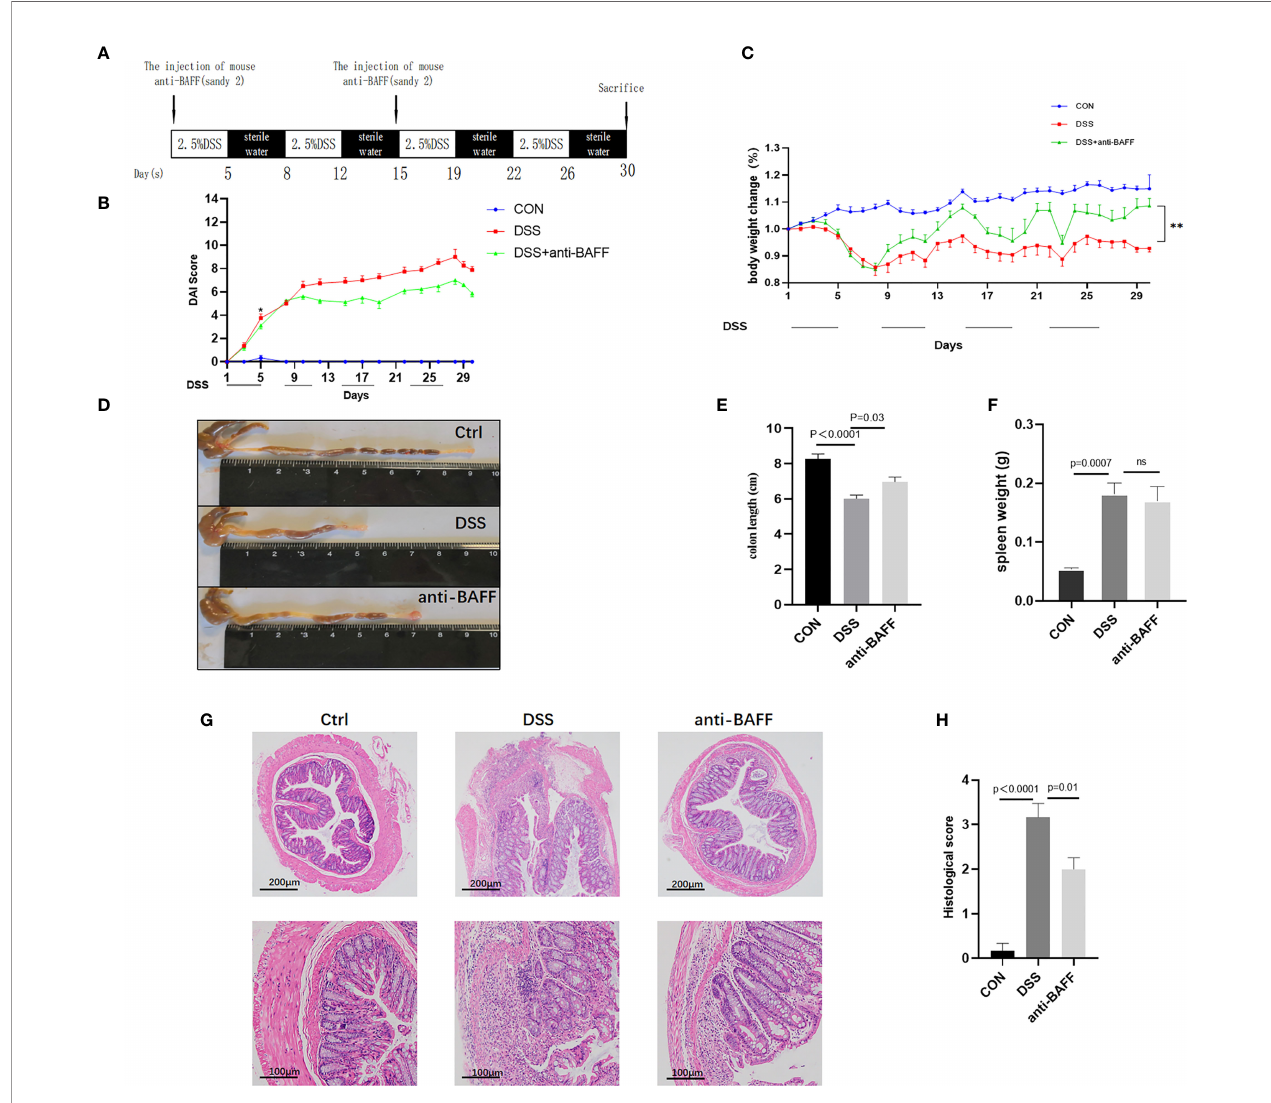
FIGURE 2 | BAFF blockade ameliorates DSS-induced experimental chronic colitis in mice. (A) Detailed process and dosage regimen of DSS and anti-BAFF antibody. (B) Disease activity index was evaluated as the combined score of weight loss, fecal consistency and fecal blood (scored as 0 – 12). (C) Body weight curve of different groups. (D) Representative gross photographs of mouse colon, (E) the colon length and (F) the spleen weight in different groups were measured. (G) Serial sections from colon tissue stained with H&E. (H) Histopathological (HAI) scores of colons from mice with DSS-induced experimental chronic colitis. The pathology images were selected to show the most typical one for each group. DSS, dextran sulfate sodium; H&E, hematoxylin and eosin. ns, p >